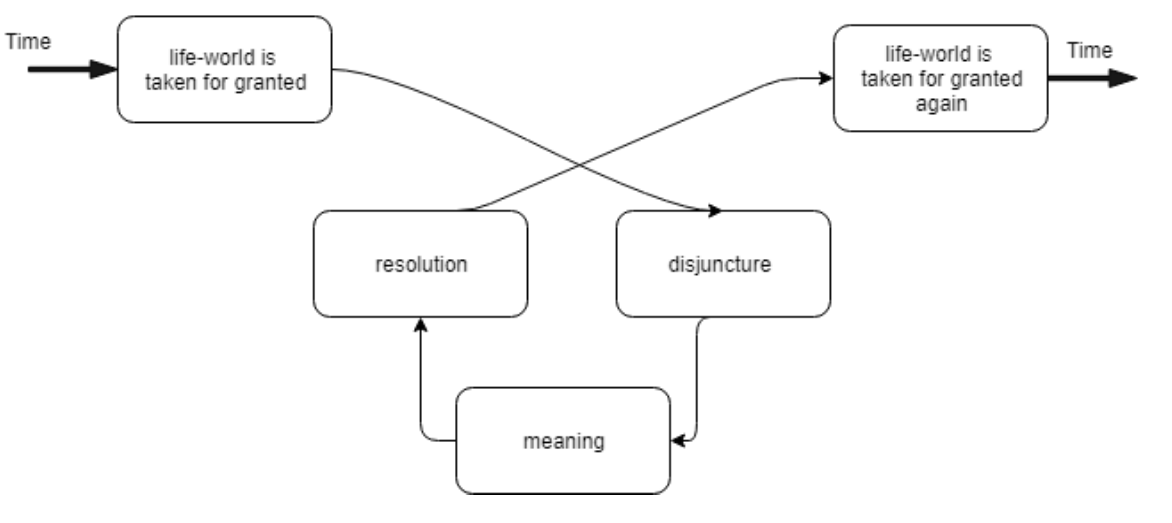
Figure 1: Jarvis' model of learning from primary experience - transformation of sensations (Jarvis, 2009, p.